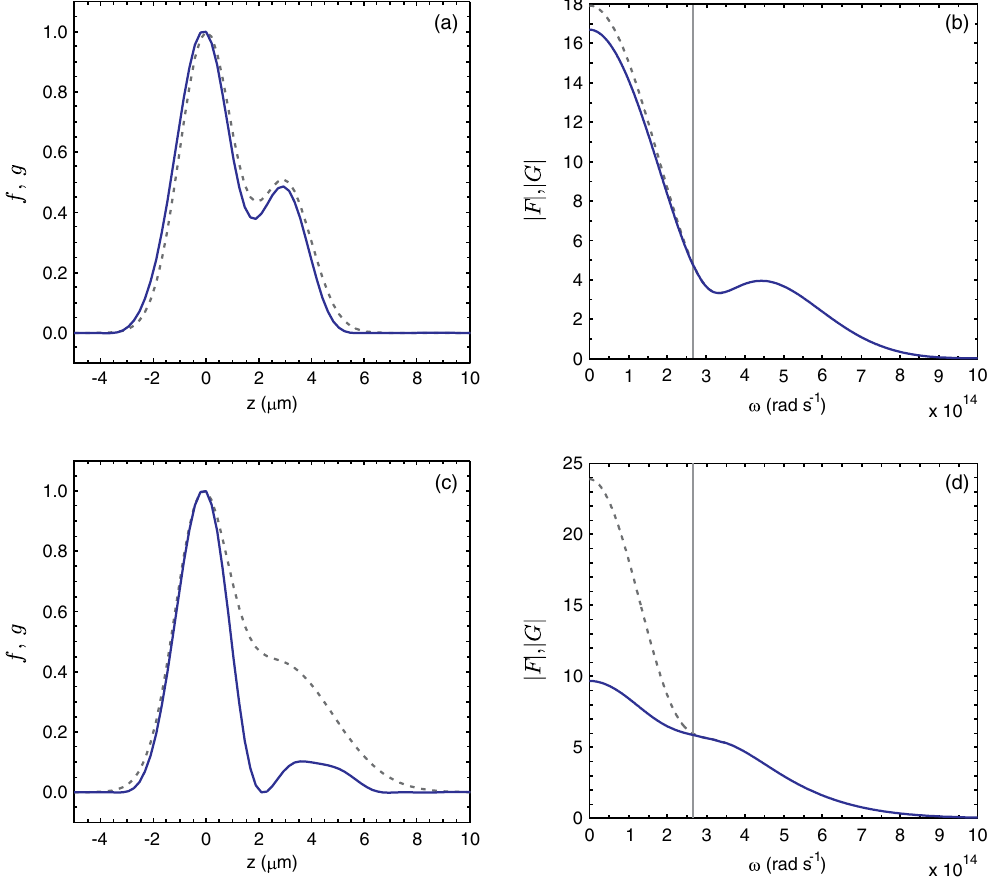
FIG. 4. Reconstruction of synthetic bunch profiles comprising two Gaussians, where the peak height of the smaller one is half that of the larger one. Initial profiles are shown as dashed gray lines in (a) and (c). The mean of the reconstructed profiles is shown as blue lines, and light blue shading represents three- (cid:7) deviation from the mean. In (a) both Gaussians have rms length 1 (cid:6) m , and their centers are separated by 3 (cid:6) m ; in (c) the separation is the same, but the smaller Gaussian has an rms length of 2 (cid:6) m . The spectral amplitudes corresponding to the original and reconstructed profiles are shown in (b) and (d).